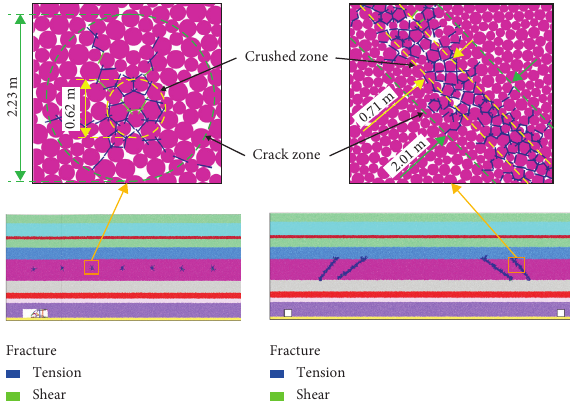
Figure 7: Ranges of damage zones induced by deep-hole blasting. (a) Strike, (b)